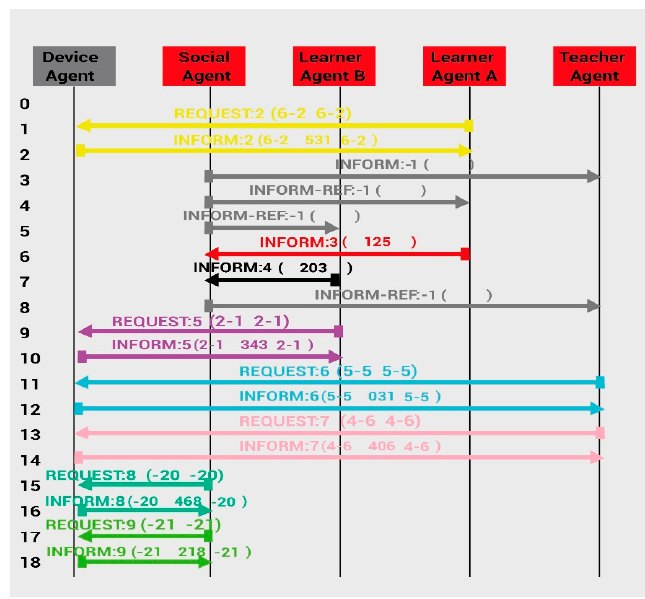
Figure 19. Simulation of interactions between agents.